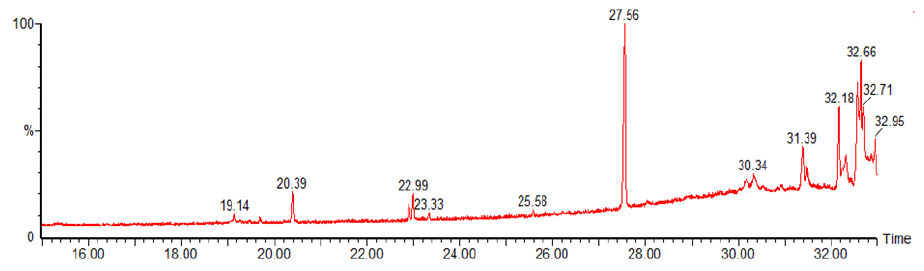
Figure 7. GC–MS spectrum of ethyl acetate extract of Quercus incana . Table 1. Compounds list by matching NIST library.